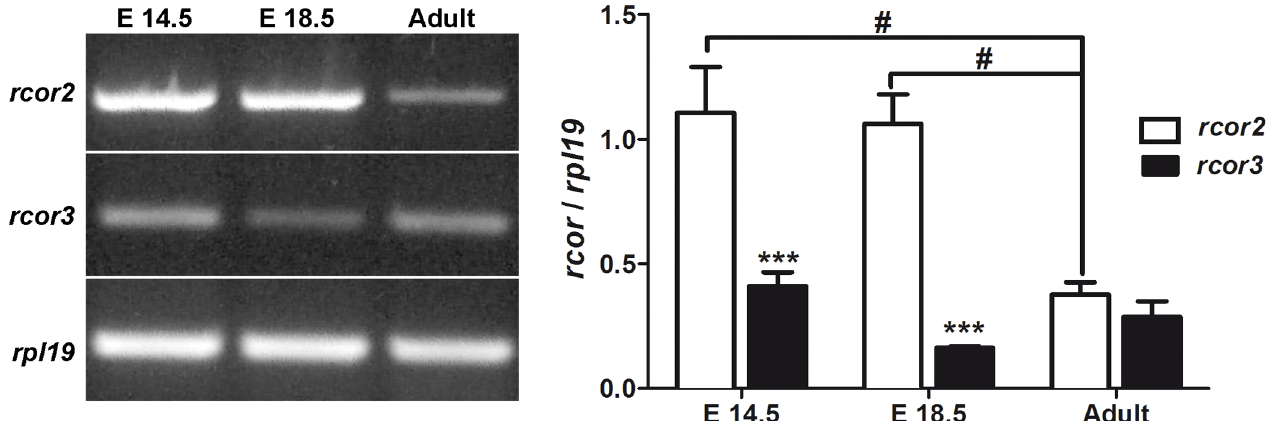
Fig 5. rcor2 but not rcor3 is down-regulated during brain development. Total RNA of E.14.5 and E.18.5 embryonic rat brain, and the cortex of adult male rats were subjected to semiquantitative RT-PCR to determine rcor2 and rcor3 mRNA expression. rpl19 was used as reference gene. Values correspond to the mean ± SEM of at least 3 independent experiments. *** p < 0.001, ** p < 0.01, according to two-way ANOVA and Bonferroni ’ s posthoc test. # P < 0.05, according to one-way ANOVA and Bonferroni ’ s posthoc